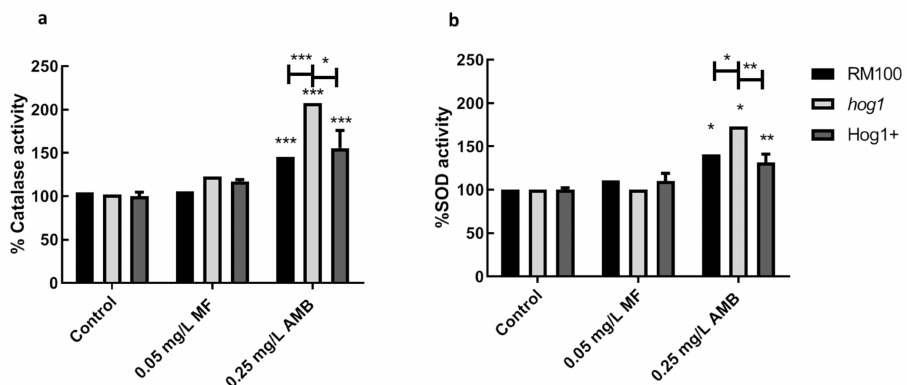
Figure 5. ( a ) Catalase and ( b ) superoxide dismutase (SOD) activities after treatment with MF and AMB. Cells were incubated in YPD with MF and AMB to the indicated concentration at 37 ◦ C for 1 h. Cytosolic extracts were obtained, and the activities were determined as it is indicated in Materials and Methods. The data show the mean ± SD of three independent experiments. * p < 0.05, ** p < 0.01, and *** p < 0.001 represent statistically significant di ff erences with respect to an untreated control according to the Mann Whitney U